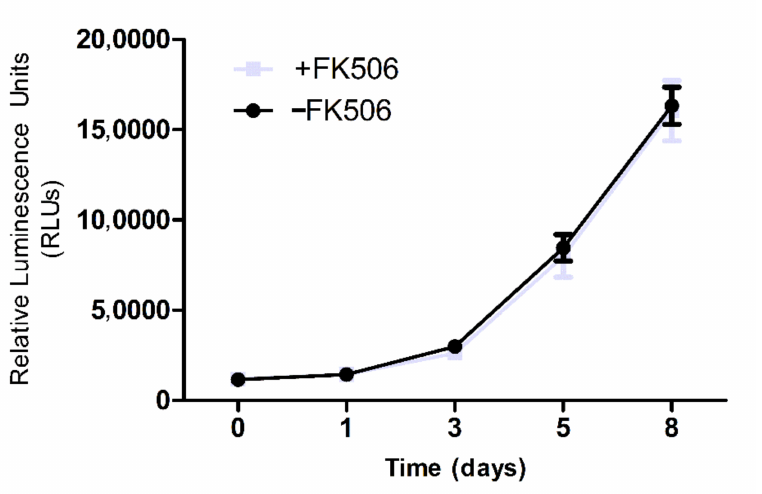
Figure 1. Growth profiles of MSC cultures in presence or absence of FK506. The growth of MSC,WJ in the two experimental settings is presented as the increase of ATP content, measured by